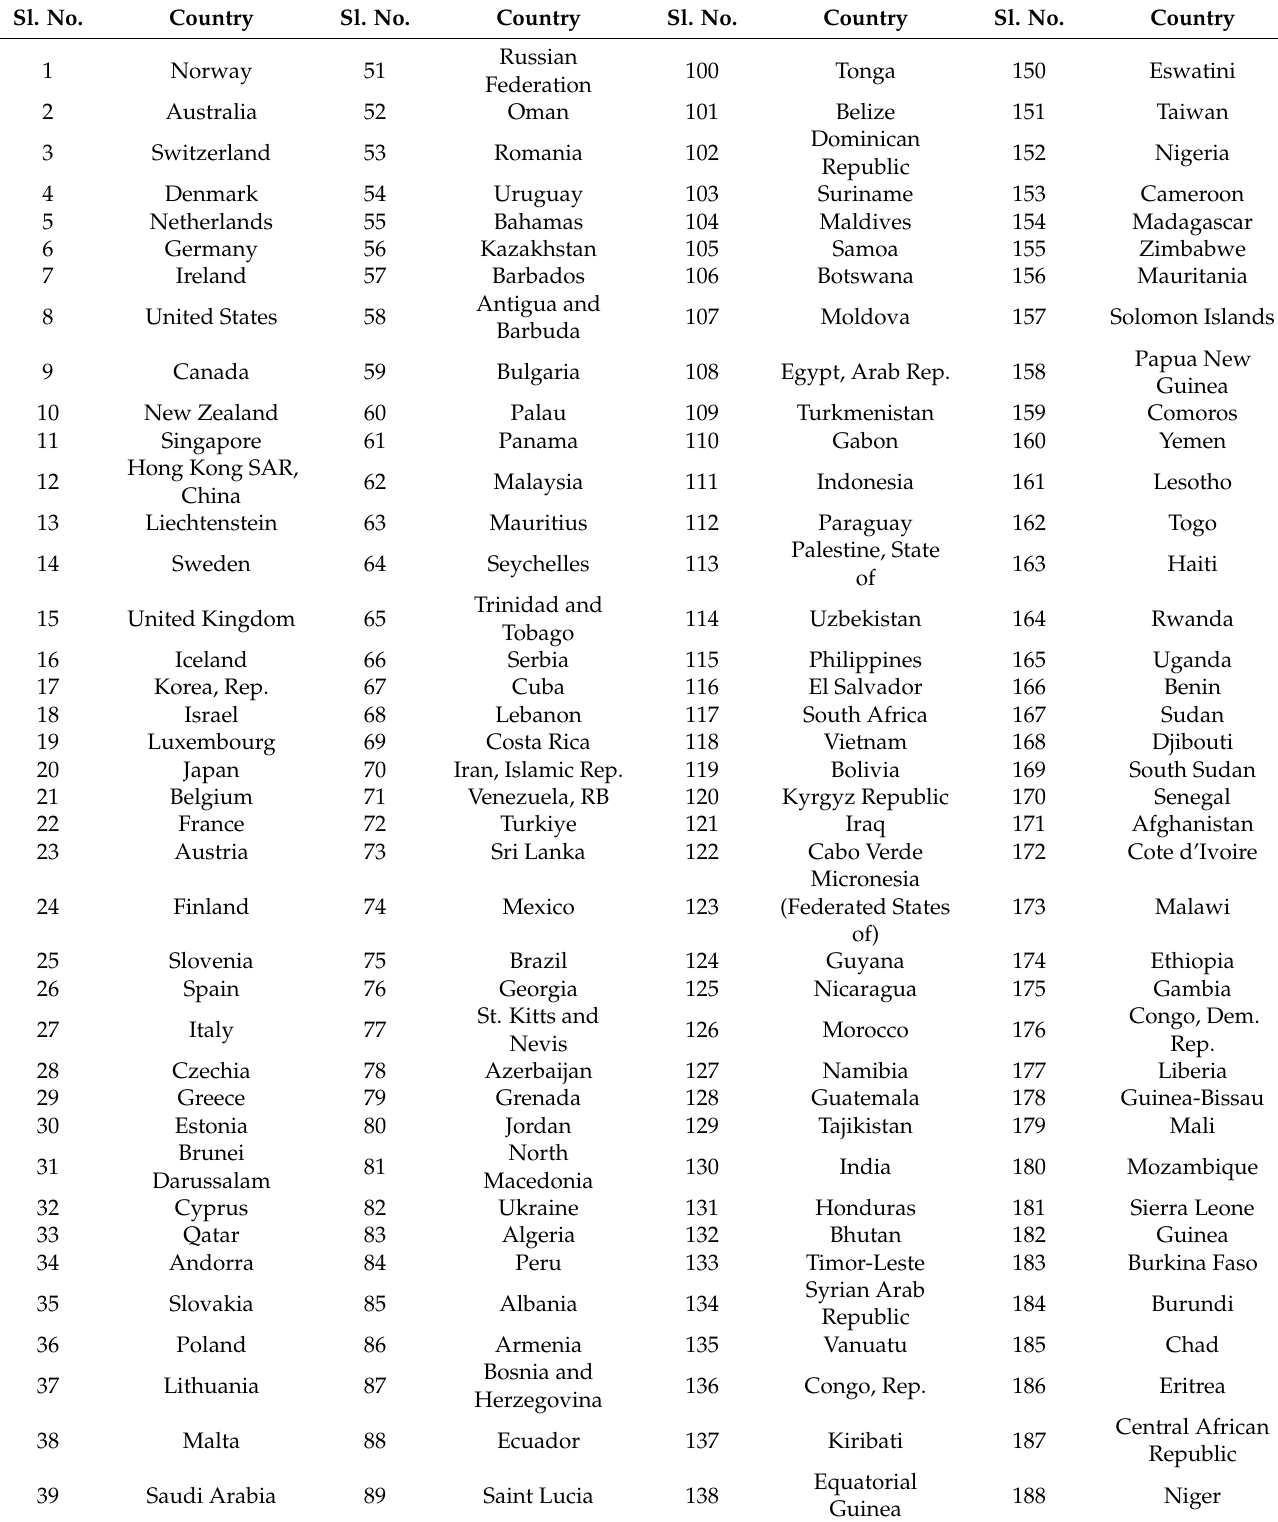
Table 1. List of countries. https://eige.europa.eu/gender-equality-index/2022/EU (accessed on 10 January